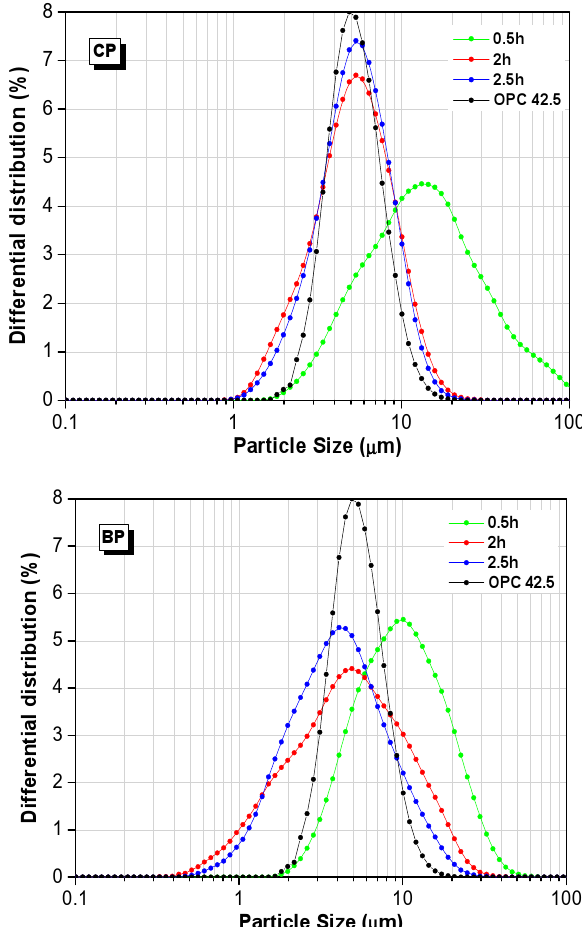
Figure 3. Particle size distribution of GP, CP, and BP after mailing for 0.5 h, 2 h, and 2.5 h. OPC, ordinary Portland cement.